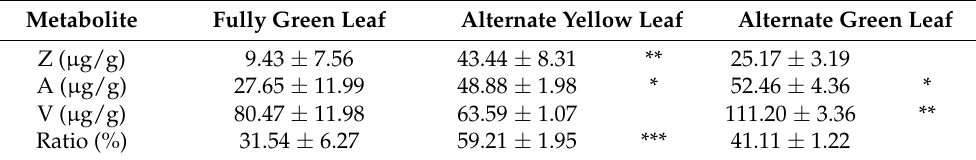
Table 2. Deepoxidation analysis of xanthophyll cycle in zebra leaves. Metabolite Fully Green Leaf Alternate Yellow Leaf Alternate Green Leaf Z ( µ g/g) 9.43 ±